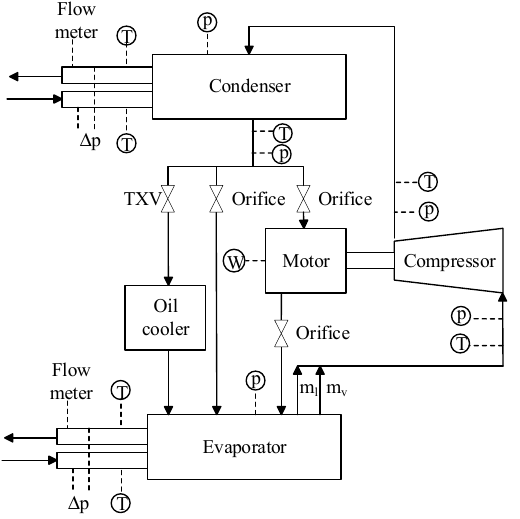
Figure 3. Arrangement of measuring points for liquid entrainment of a centrifugal chiller. Table 1. Measurement parameters and